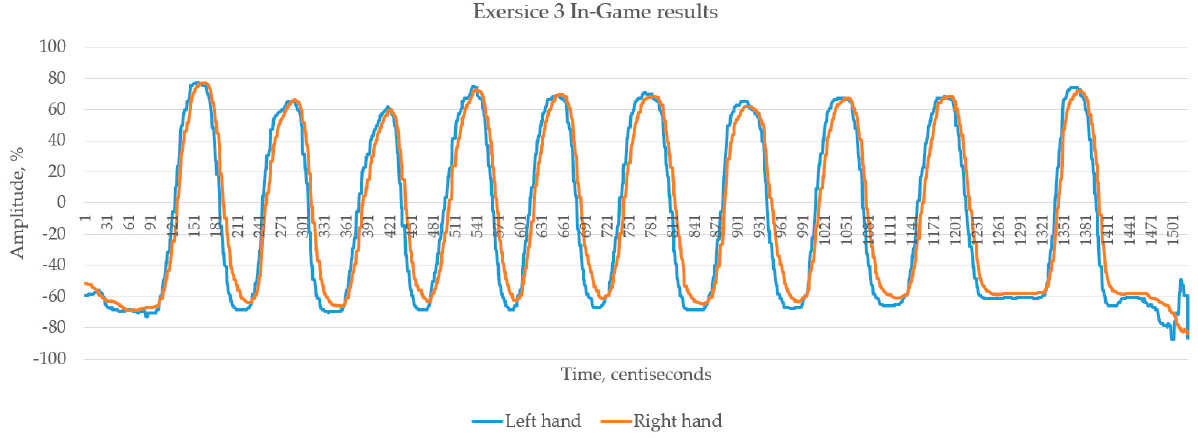
Figure 10. Result of game performance in Exercise 3.